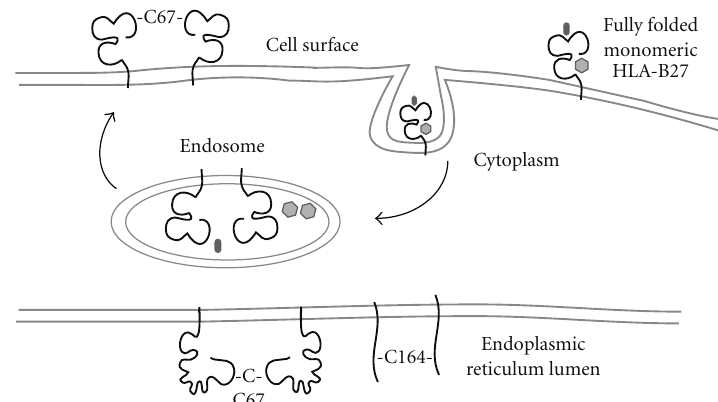
Figure 4: Schematic illustrating that ER resident and cell surface dimers are not related. ER resident dimers can form via C67-C67 or C164- C164 disulfide bonds, but do not transit out o ff the ER. Cell surface dimers are thought to form following the recycling of fully folded HLA-B27 cell surface molecules through the endocytic pathway before being reexpressed as dimers mediated by C67-C67